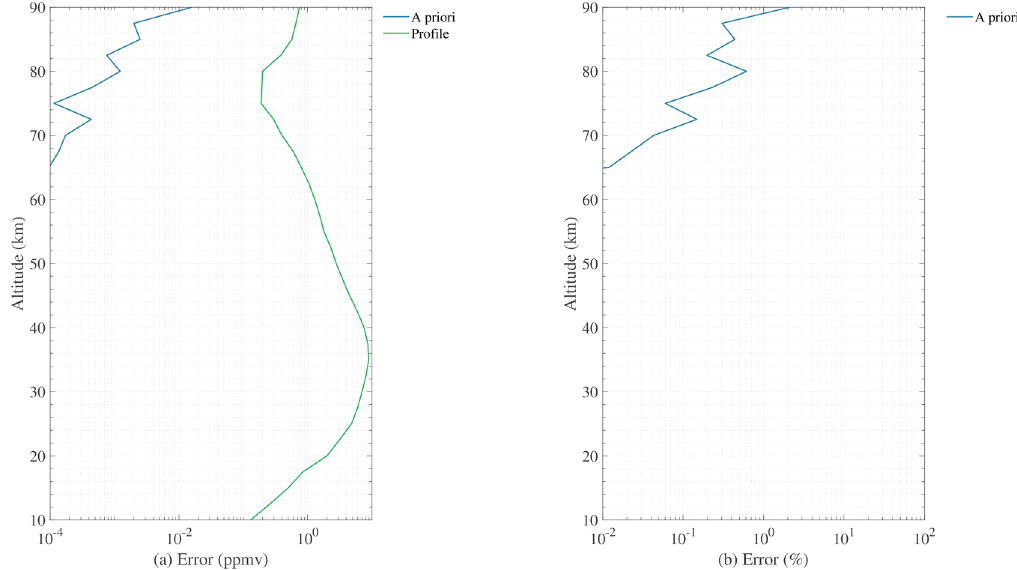
Figure 16. The O 3 retrieval error induced by external error source: ( a ) absolute and ( b ) relative retrieval errors. The uncertainties assumed are summarized in Table 5.